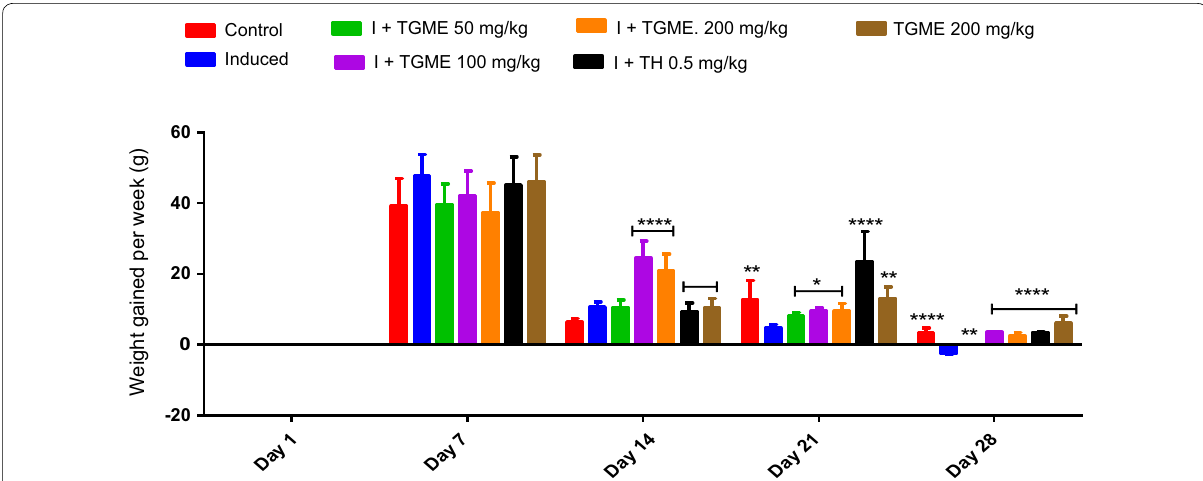
Fig. 3 Effect of aqueous methanolic leaf extract of Triclisia gilletii on body weight gained per week in animals administered ethane-1,2-diol. Data are expressed as mean SEM of 6 rats ( n 6); * p < 0.05, ** p < 0.01, and **** p < 0.0001; * denotes that data were compared with ethane-1,2-diol; TGME ± = Triclisia gilletii aqueous methanolic extract, TH tamsulosin